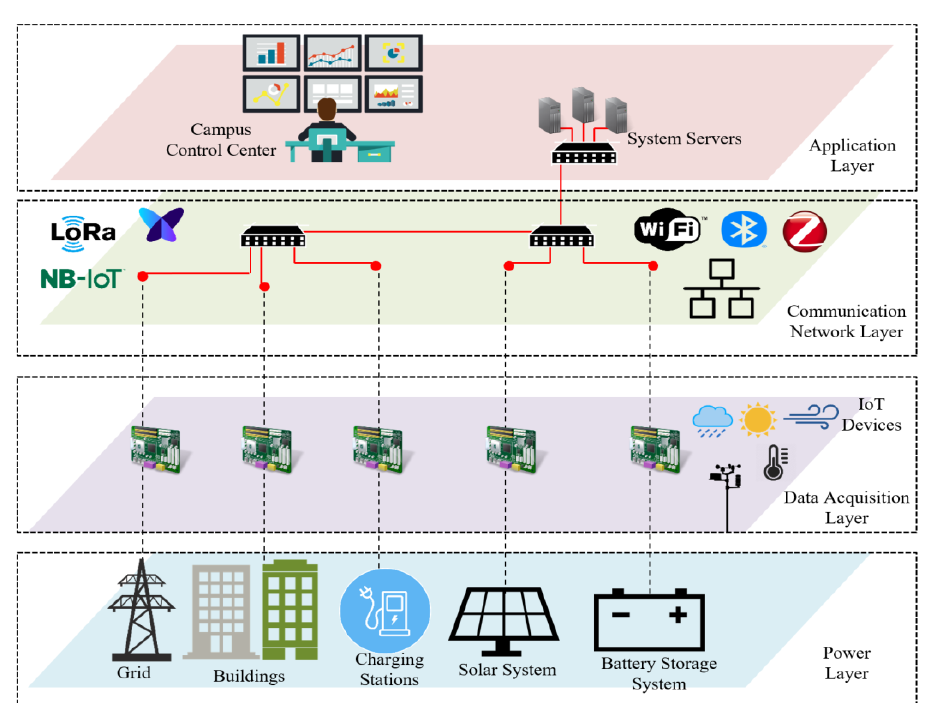
Figure 3. IoT-based architecture for the intelligent